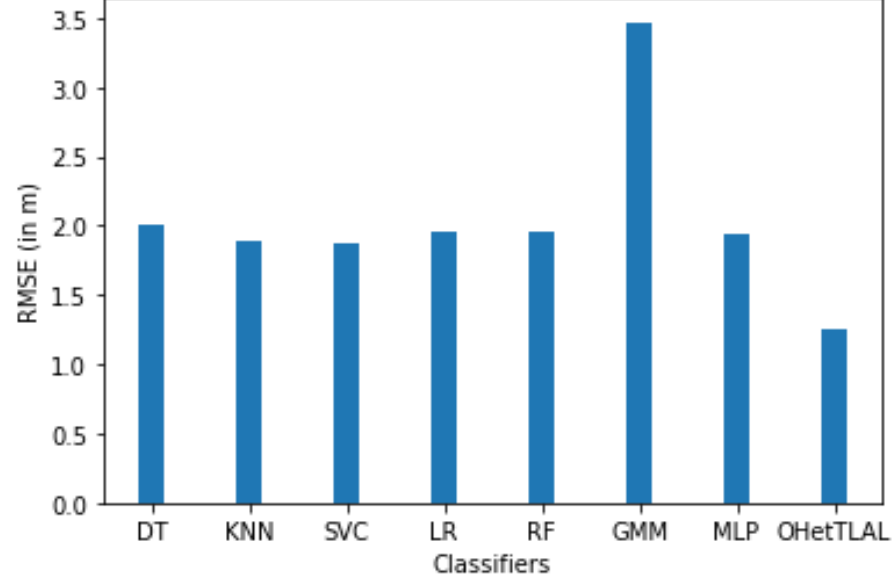
Figure 20. Comparisons of classifier’s RMSE (in meter) for dataset B with 9 Wi-Fi APs.